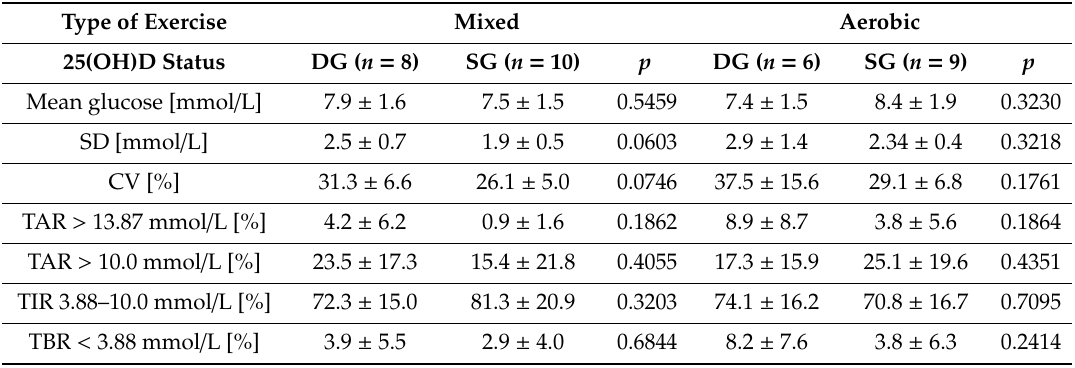
Table 3. Comparison of glycaemic control parameters during days of aerobic and mixed exercise according to 25(OH)D